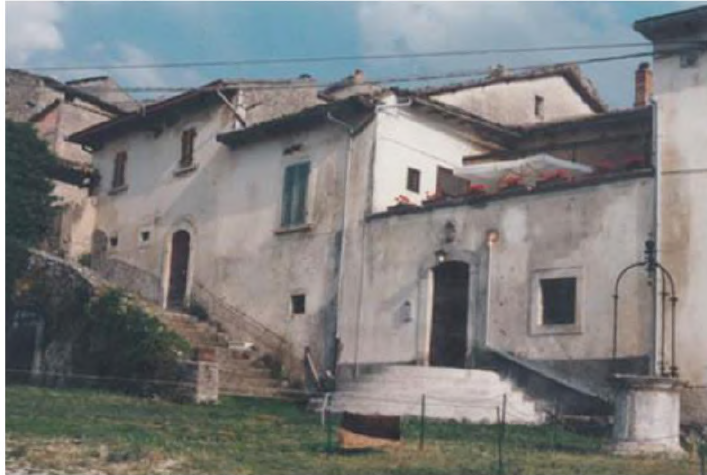
Figure 1. Photo of the “Palitti” Palace, before the 2009 earthquake.